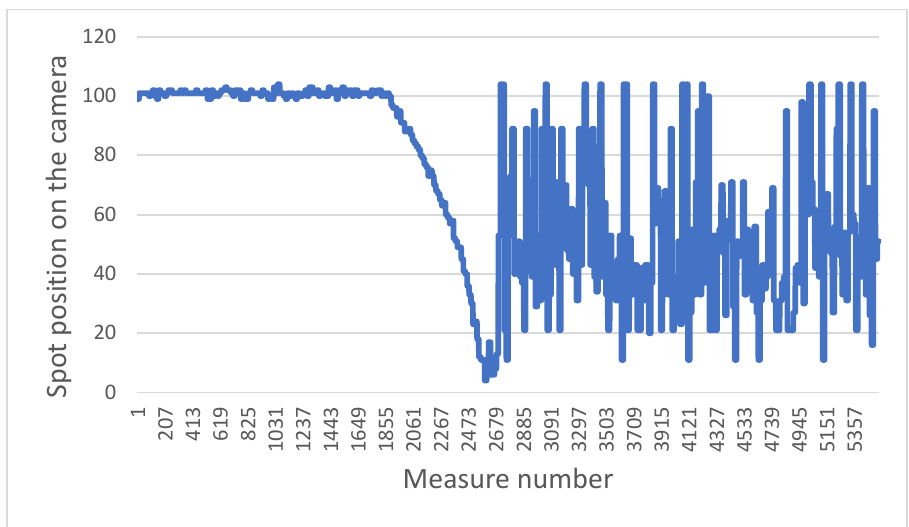
Figure 14. Evolution of position measured while the wheelchair moves toward a wall until the signal is lost.